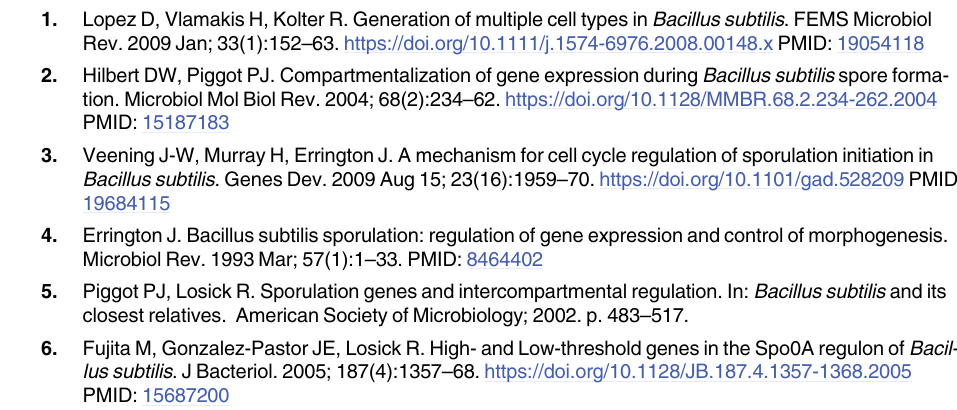
S2 Fig. Separation of mixed cultures. For all measured samples, dashed lines show the pre- dicted normal distributions of mostly bimodal cell/spore distributions as determined by Gaussian mixture modeling. (A) S2A Fig shows samples after 30 minutes. (B) S2B Fig shows samples after 90 minutes of staining. S3 Fig. Raw scatter plots of Fig 4B. Raw scatter plots of data used in Fig 4B: triplicates of Bs02003 and Bs02025 shown as scatterplots of side scatter and SYBR1 fluorescence. (TIFF) S1 Text. Viability assessment after staining.